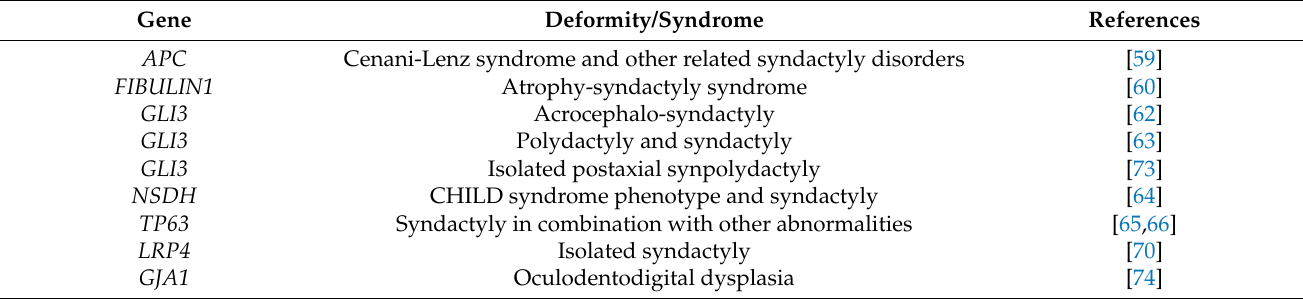
Table 2. Genes linked with the excluded types of